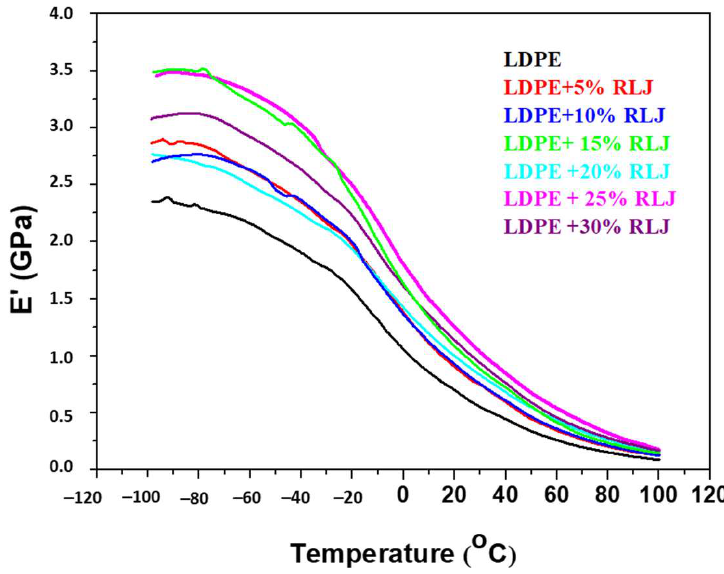
Figure 13. Storage modulus (E”) as a function of temperature of the neat LDPE and LDPE/RH biocomposites containing different RH